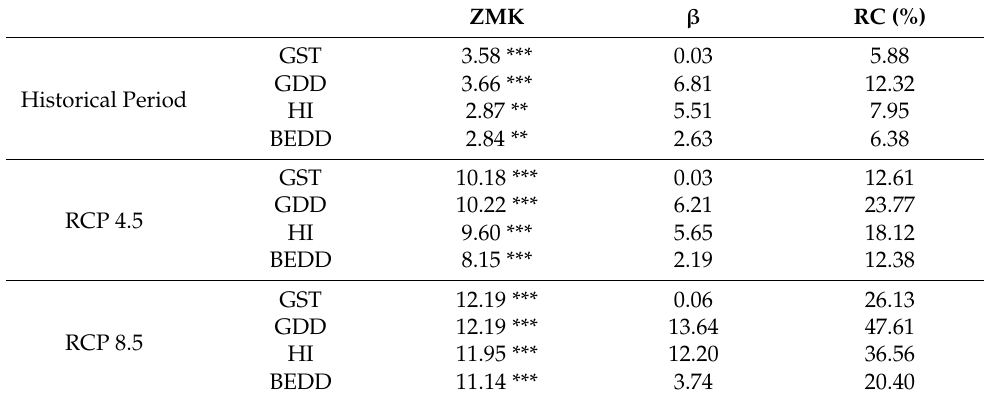
Table 4. Statistics of the Mann-Kendall test (ZMK) and the magnitude of trends approximated by Sen’s estimator ( β ) for each bioclimatic index, considering the historical period and all years until the end of the 21st century for each scenario. RC is the relative